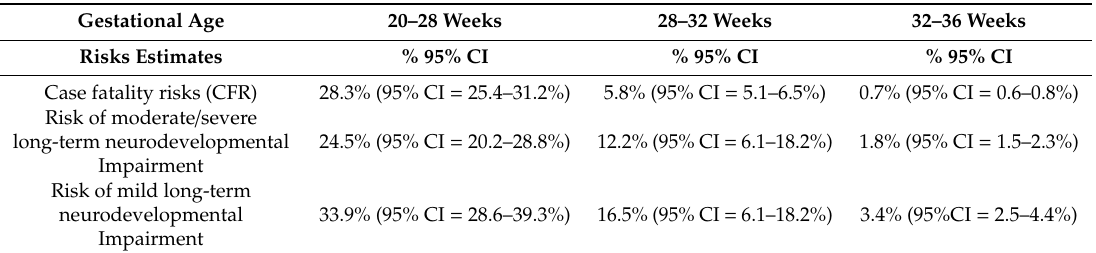
Table 1. Input data of the compartmental model for preterm birth born around the year 2010 (Blencowe et al., 2013